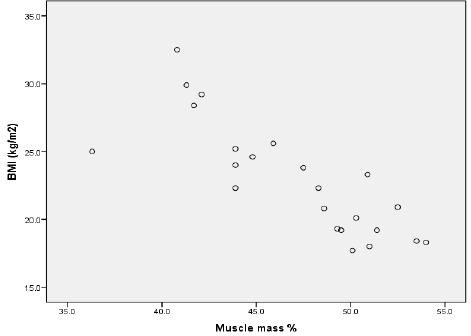
Figure 2. Correlation between BMI and muscle mass % for the group of boys without ID. For the group of boys with MID, we find the same very strong positive correlation between BMI and body fat in percentages r = 0.809 ( p < 0.001) (Annex 2, Figure 3), but concerning the correlation between BMI and the percentage muscle mass, there is a weak negative correlation, for r= −0.288 (Annex 2, Figure 4). Figure 3. Correlation between BMI and body and fat % for the group of boys MID.